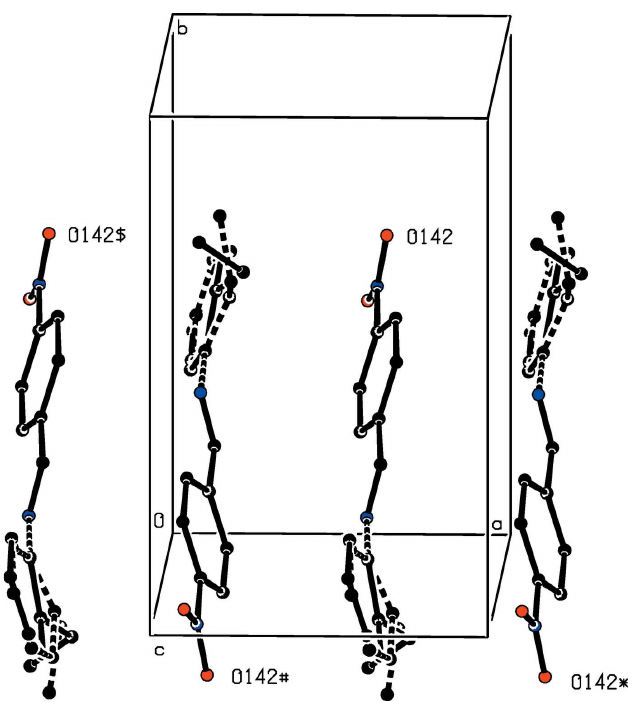
Figure 3 Part of the crystal structure of compound (I) showing the formation of a chain along [100] built from nitro (cid:2)(cid:2)(cid:2) (cid:2) (arene) interactions. For the sake of clarity, the H atoms have all been omitted. The atoms marked with an asterisk (*), a hash (#) or a dollar sign ($) are at the symmetry positions (cid:5) y , 1 (cid:5) z ), ( (cid:5) 1 (cid:5) y , 1 (cid:5) z ) and ( (cid:5) 1 + x , y , z ), respectively. ( 1 + x , 1 + x , 1 2 2 2 2 For the disordered 2-ethylphenyl group, the major component is drawn using solid lines and the minor component is drawn using dashed